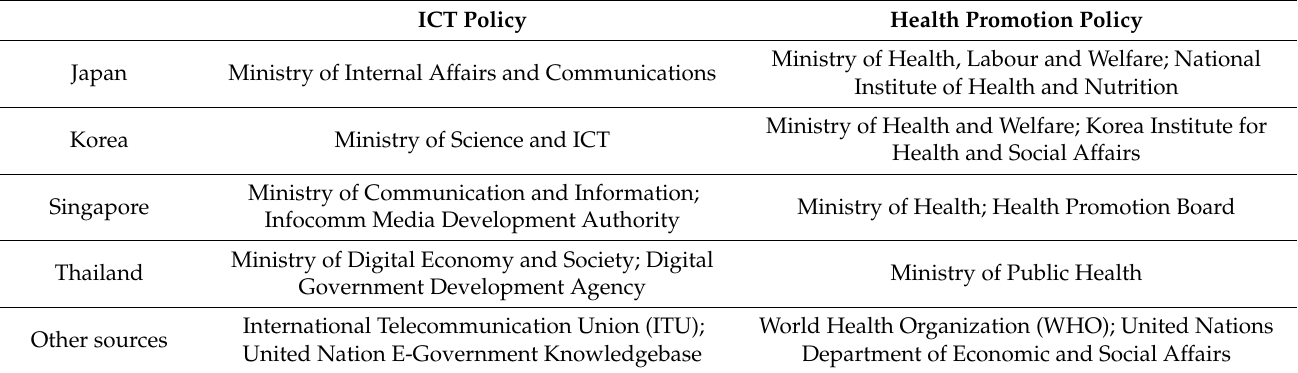
Table 1. Main review sources for each